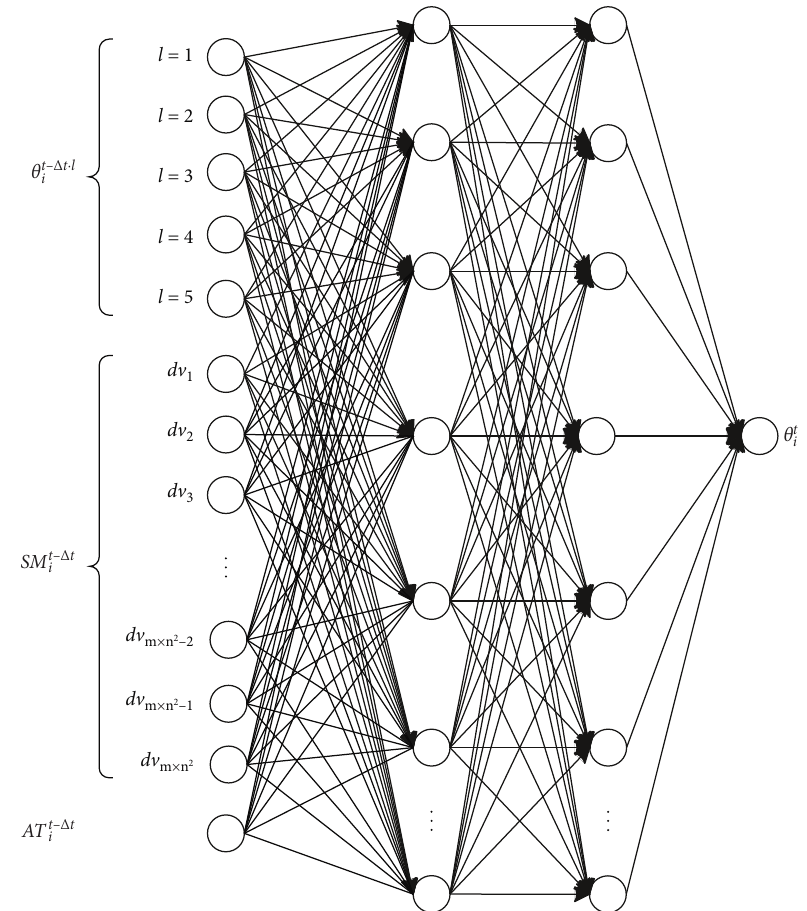
Figure 6: Architecture of the neural network in the velocity direction angle submodel (VDASM).